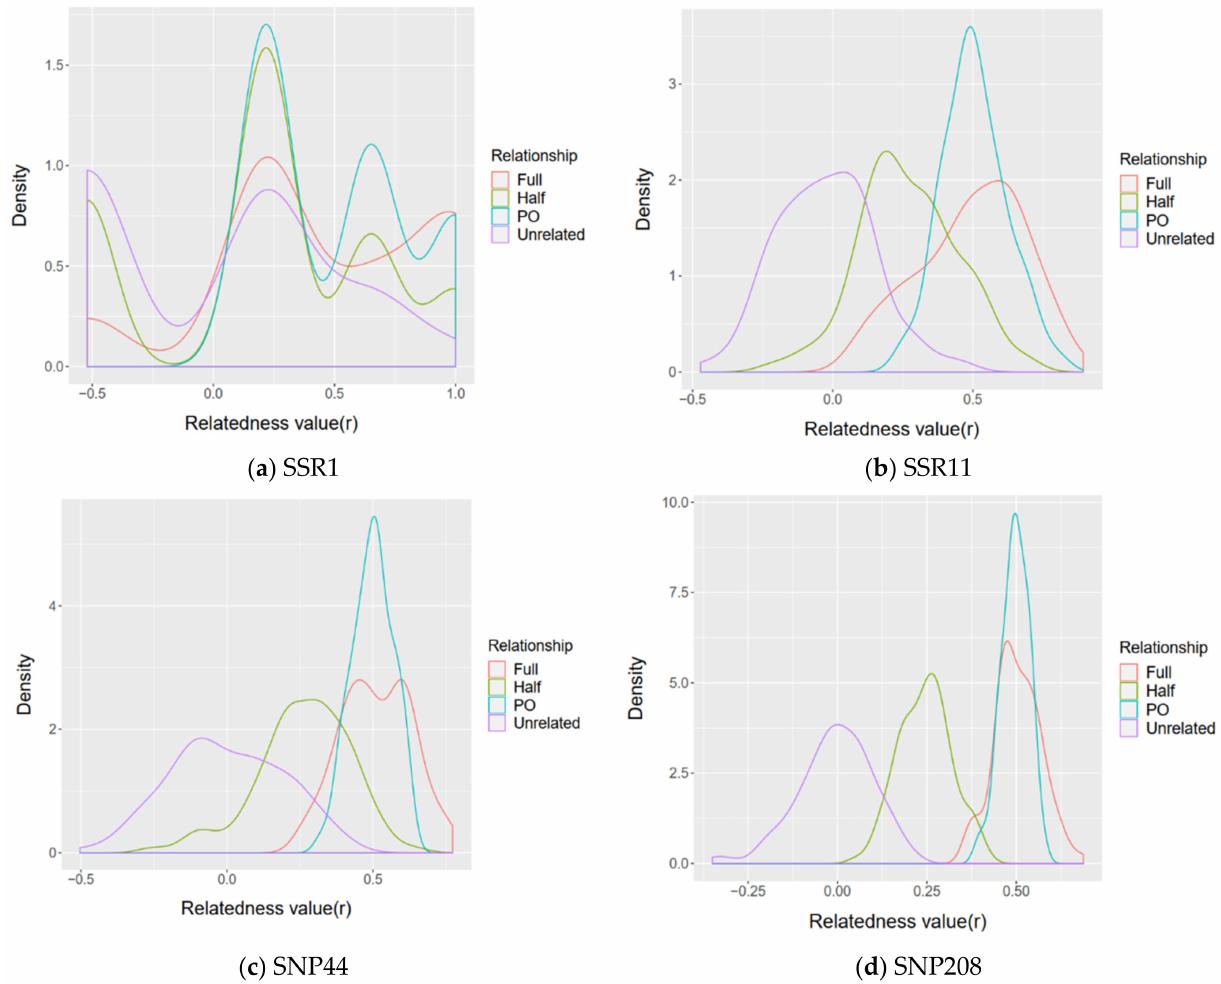
Figure 3. Density plots of relatedness values for simulated pairs of known relatedness (unrelated, half-sibling, full-sibling and parent–offspring) based on given population allele frequency of different marker panels: ( a ) the microsatellite panel SSR1 composed of 1 microsatellite locus; ( b ) the microsatellite panel SSR11 composed of 11 microsatellite loci; ( c ) the SNP panel SNP44 composed of 44 SNP loci (MAF cut-off > 0.475); ( d ) the SNP panel SNP208 composed of 208 SNP loci (MAF cut-off >